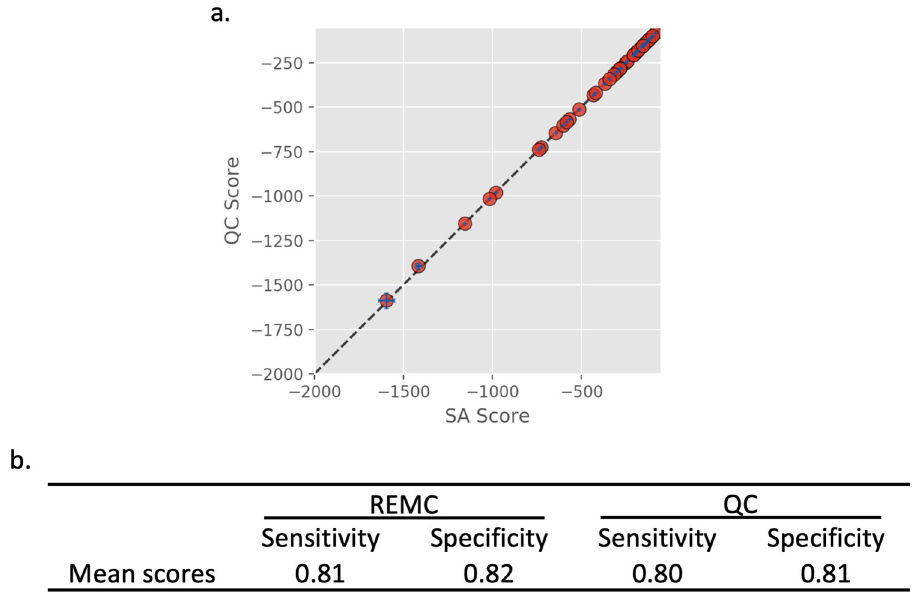
Fig 3. Replica Exchange Monte Carlo (REMC) and Quantum Computing algorithms were tested on systems containing more than 45 stems, which exceeds the practical limit of what can be solved with exact enumeration. The eigenvalues of the lowest energy systems are compared in (a). The dashed line represents y = x.